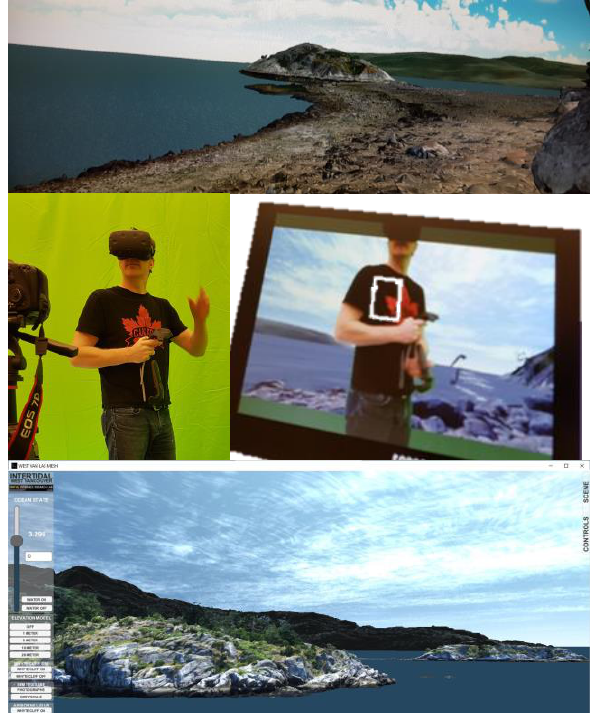
Figure 4. Views from inside and outside of Intertidal VR – and immersive virtual reality system allowing municipal planners and citizens to walk around a 1cm-resolution virtual intertidal space, and interactive control total sea-level (with segmented mean sea-level, storm state), and not just observe, but experience its potential impact on a familiar community coastal space.